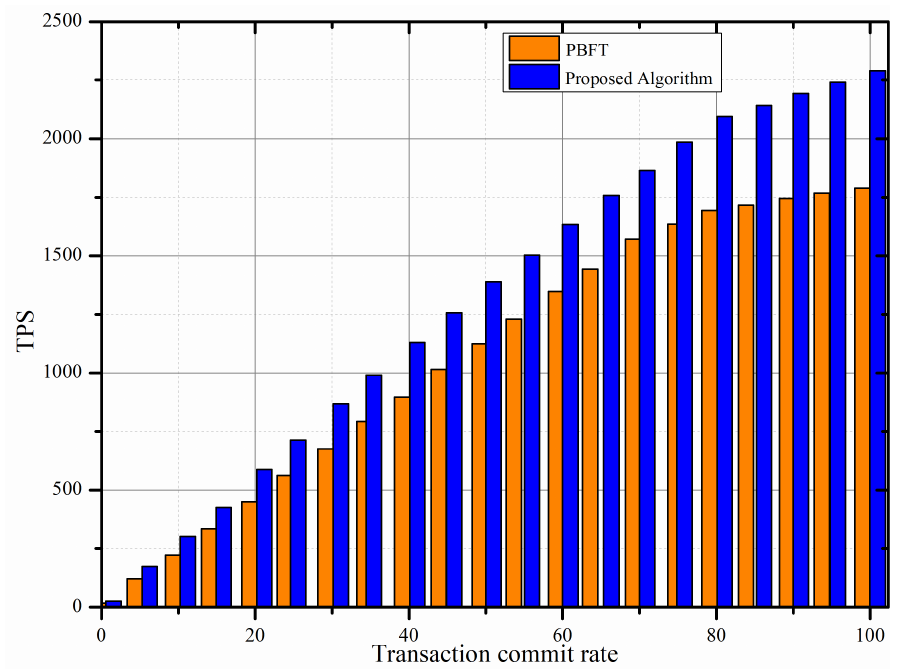
Figure 7. Throughput